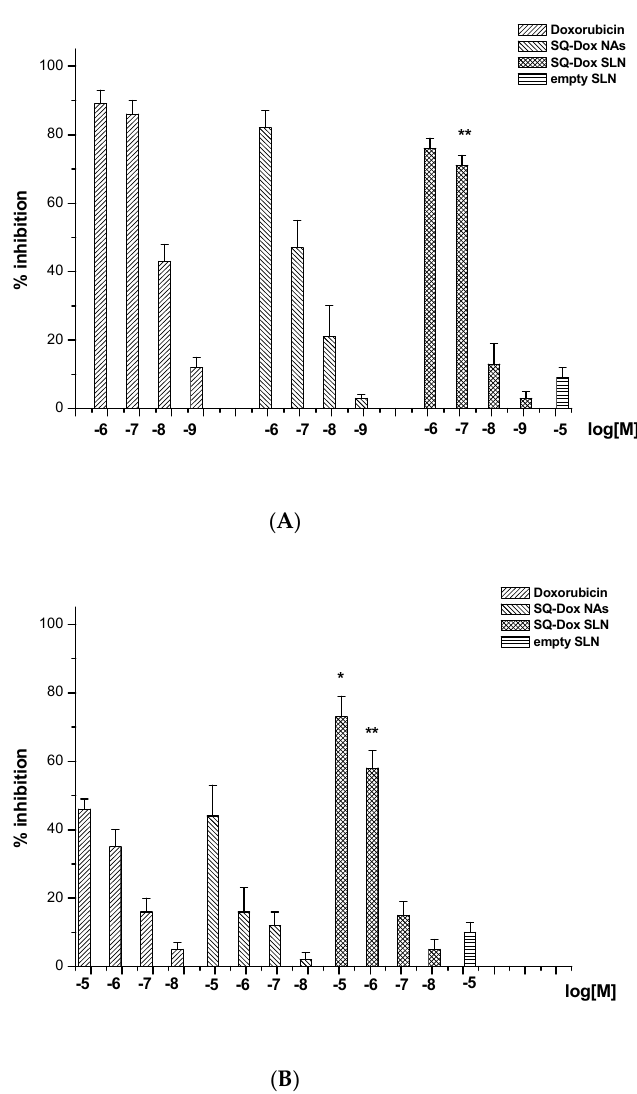
Figure 4. The effects of Dox, SQ-Dox NAs and SQ-Dox SLN1 treatment on cell clonogenicity were tested by a colony-forming assay of A2780 ( A ) and A2780 res ( B ) cell lines. One-way ANOVA